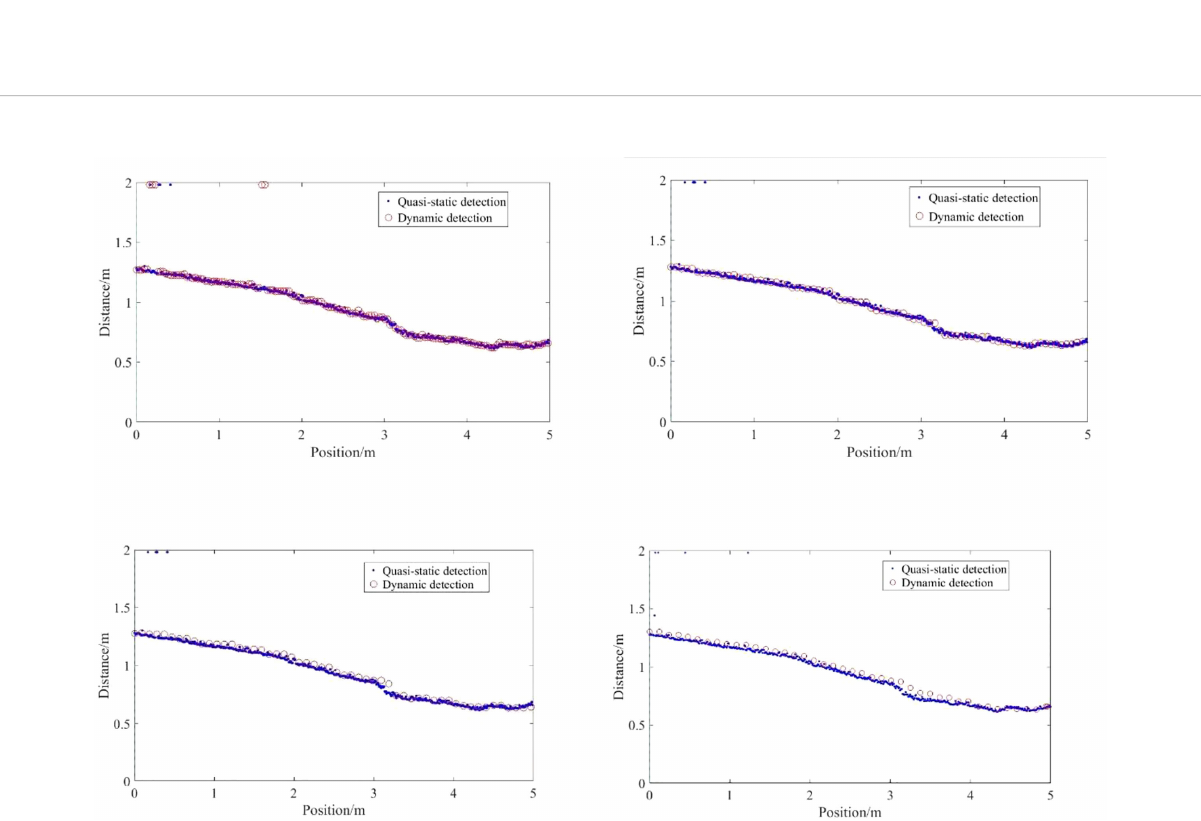
FIGURE 17 Detection distance of ultrasonic sensor for the regular steps. During the detection of bare soil, there is no obvious lag of the relative quasi-static actual position 0.3m/s, 06 m/s, 0.9 m/s, 1.2 m/s.